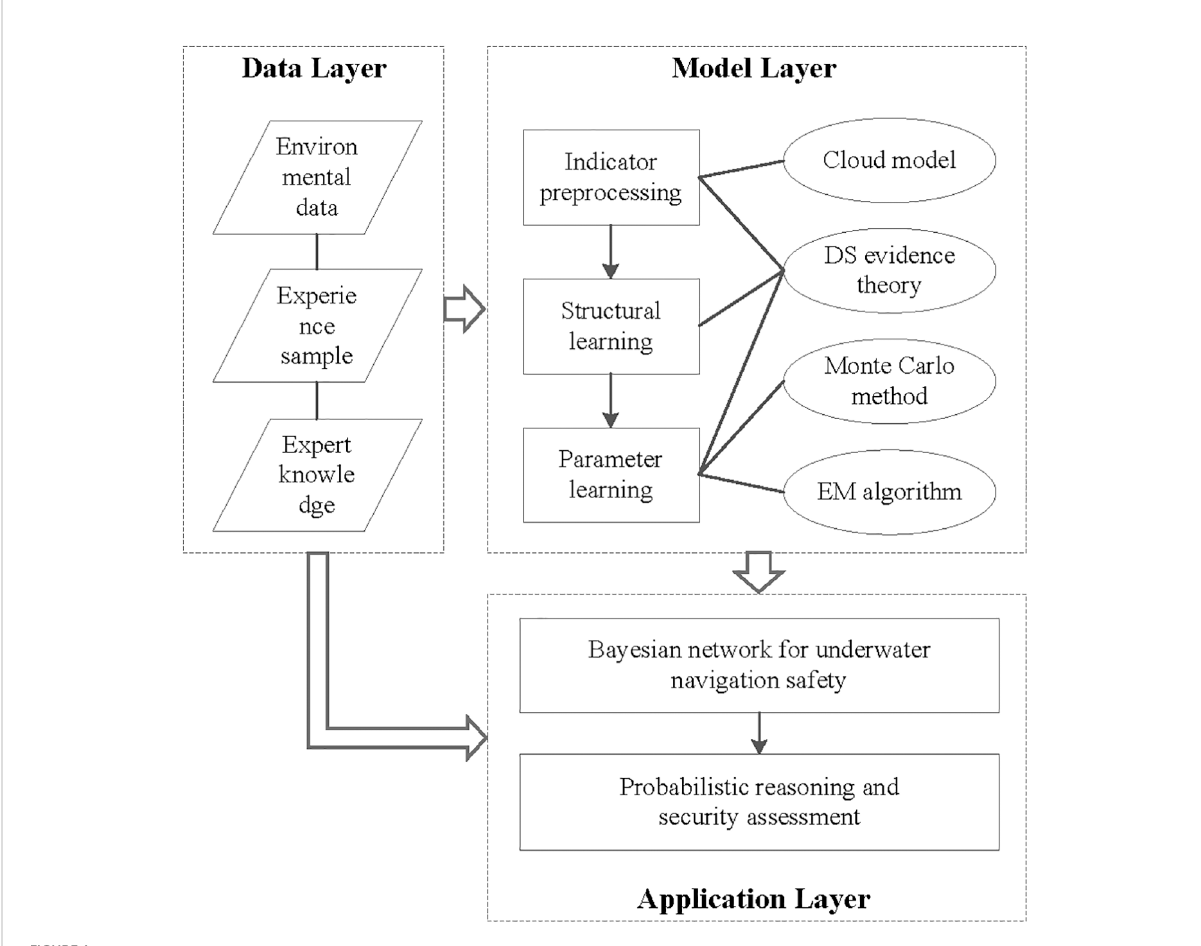
FIGURE 1 Assessment modeling route based on